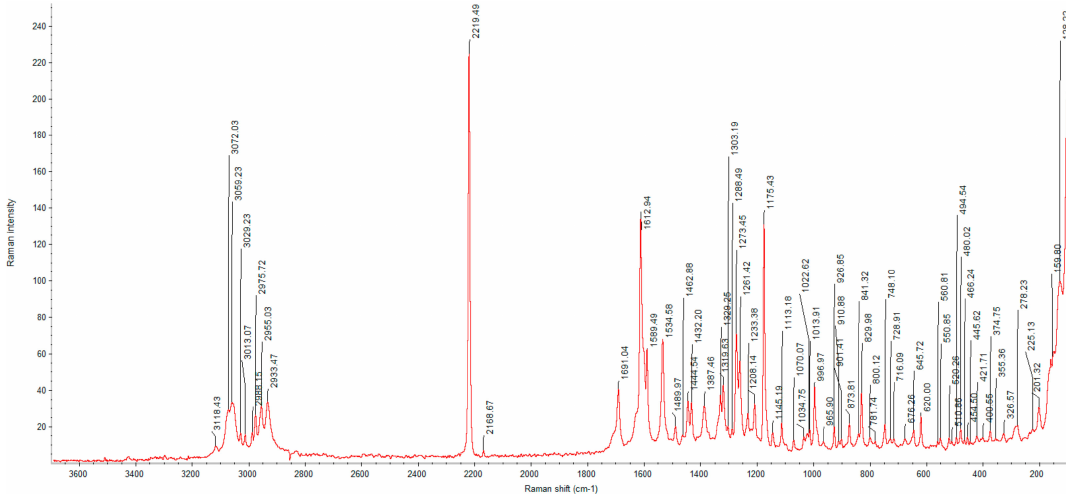
Figure 5. Raman spectrum of glasdegib